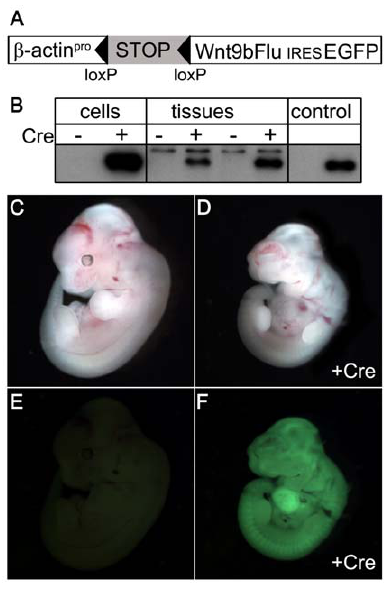
Figure 1. Transgene and GFP expression depends on cre in cells and tissues. (A) Schematic of the transgene construct showing the b -actin promoter ( b -actin pro ), the stop cassette (STOP) flanked by lox P sites (triangles), the epitope-tagged Wnt9b cDNA (Wnt9bFLU), an internal ribosomal entry site (IRES) and green fluorescent protein cDNA (GFP). (B) Epitope-tagged Wnt9b protein is expressed when the transgene is introduced into Cos-1 cells (lanes 1, 2) and E11.5 transgenic embryos (lanes 3–6) only when cre recombinase is present (cre + ). There is a higher molecular weight background band present in the tissue lysates that is not altered by the presence of cre. Lane 7 is empty. A positive control vector that lacks the lox-STOP cassette expresses Wnt9b-FLU in the absence of cre (lane 8). Brightfield (C–D) and fluorescence (E, F) images of Wnt9b transgenic E11.5 embryos with (D,F) and without (C,E) b -actin -cre demonstrate GFP expression and delayed embryogenesis for the Wnt9b tg/ + , b -actin -cre tg/ + embryos.